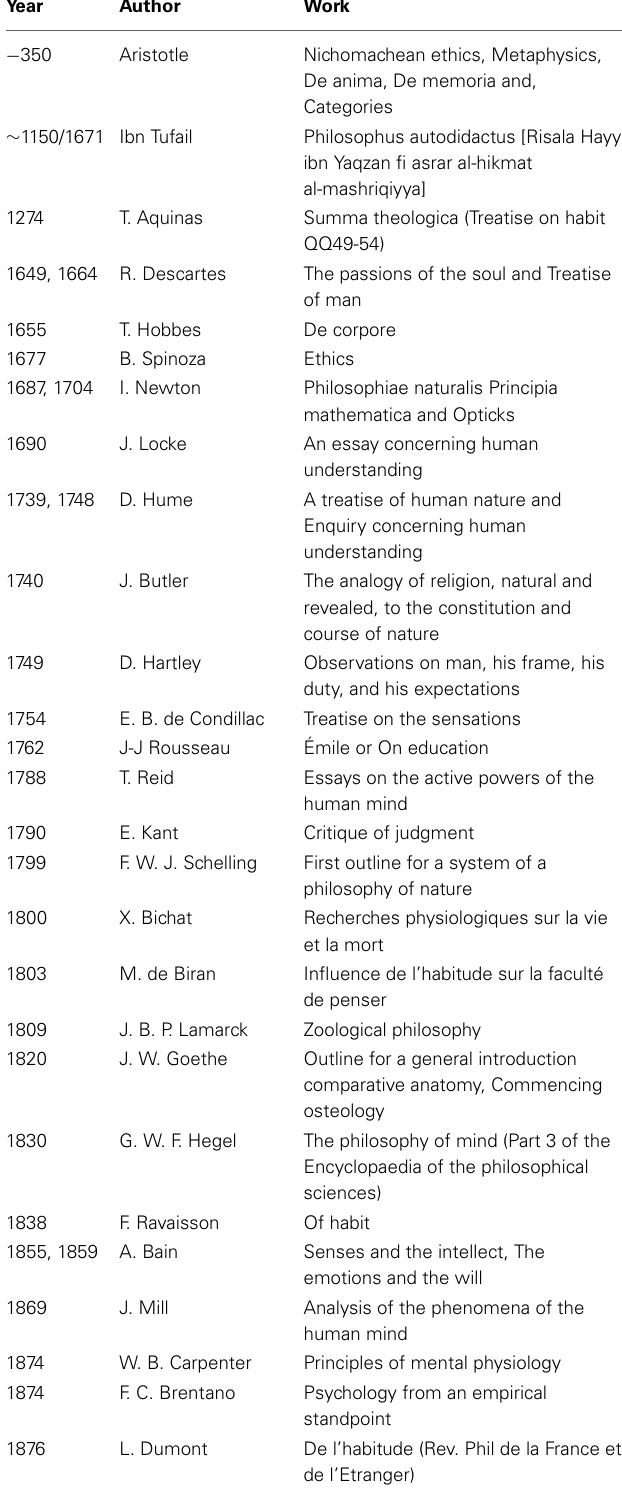
Table 1 | List of authors and their most significant work related to habits. The year corresponds to the original publication and the title to the English translation (if